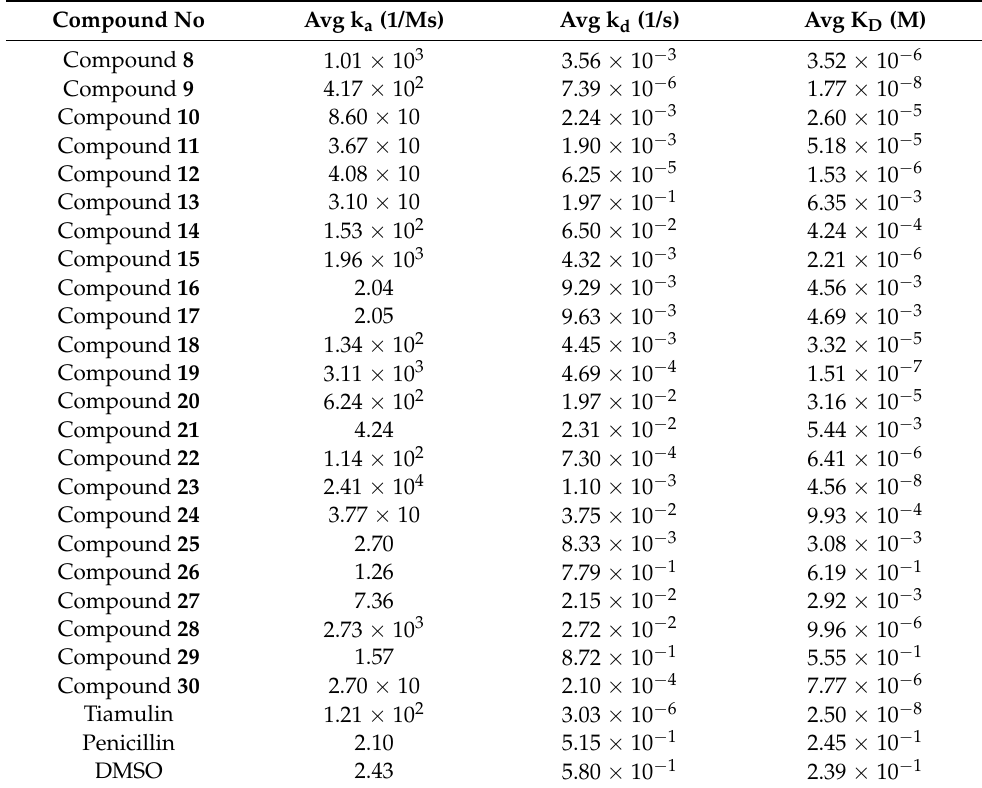
Table 2. Binding affinities of compounds and controls between the 50S ribosome.